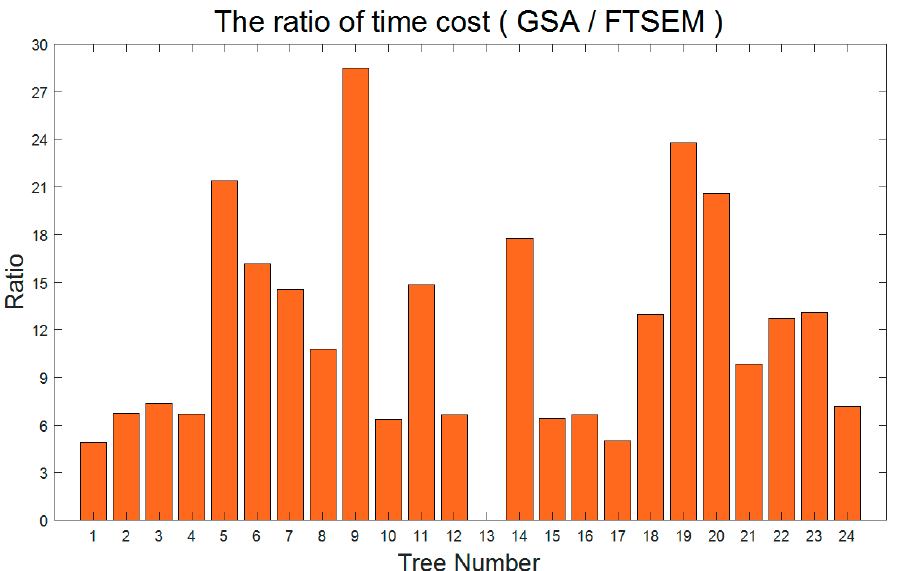
Figure 9. The time cost ratio of GSA and FTSEM.